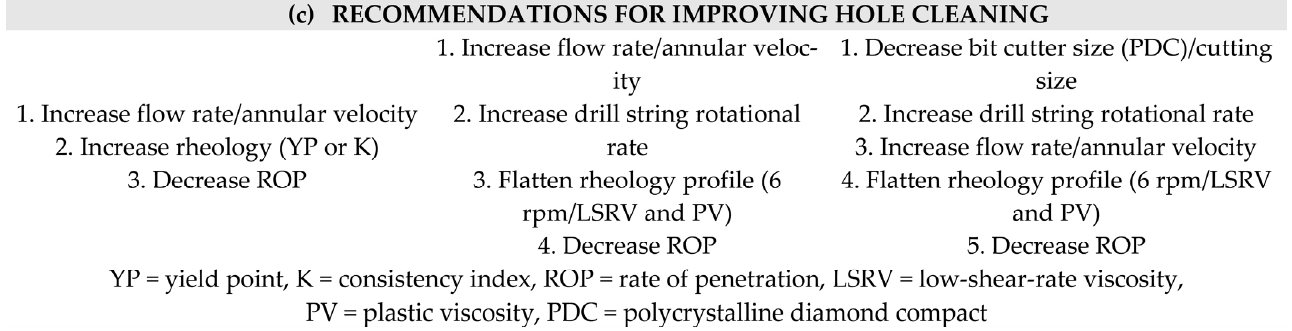
Figure 3. Hole cleaning in extended-reach wells (cleaning zones ( a ), influence of gravity and hole inclination ( b ) and recommendations for improving ( c )).